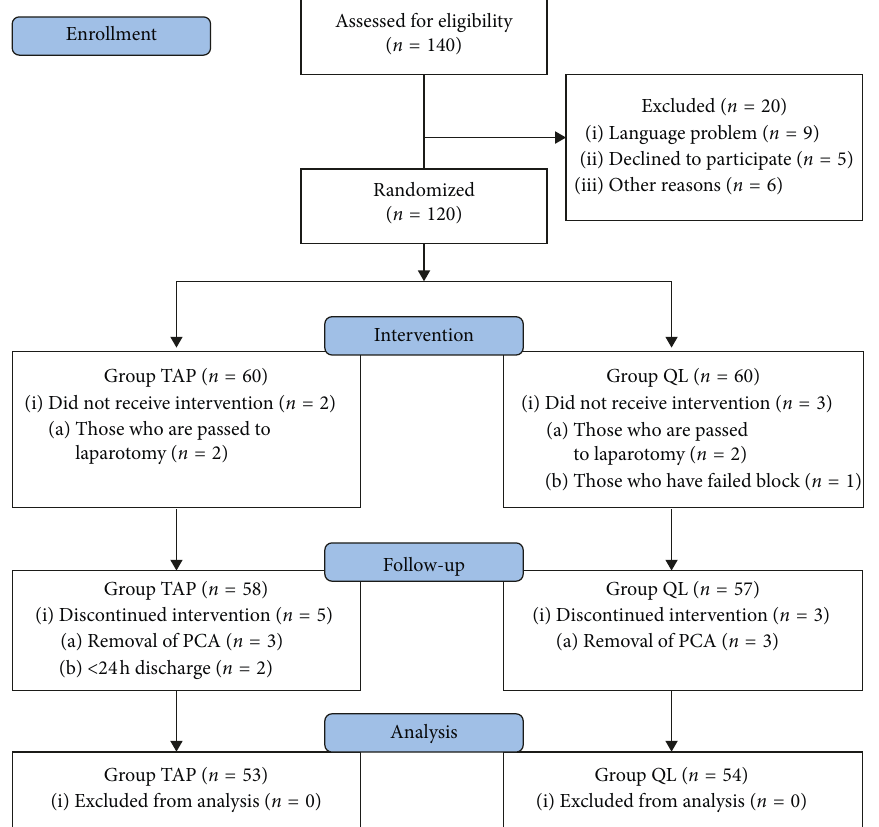
Figure 1: Trial flow diagram. Table 1: Demographic and clinical